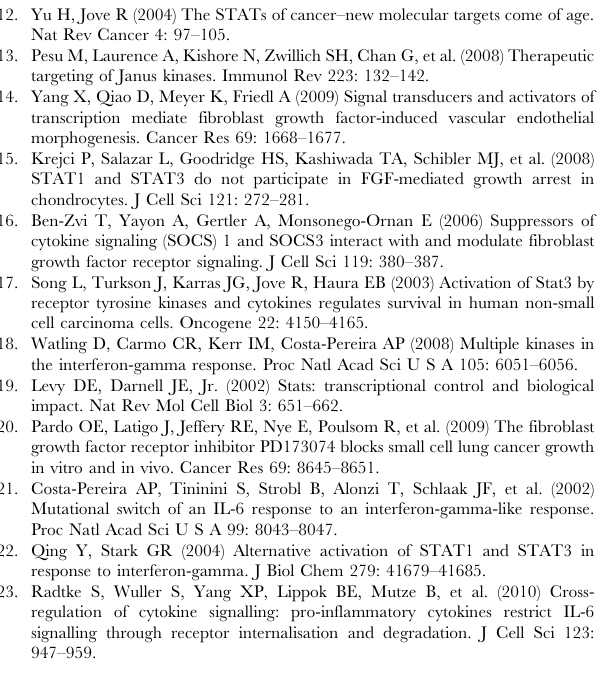
Figure S3 FGF-2 induced interactions between S6K2, gel and analyzed by western blot. Membranes were probed for